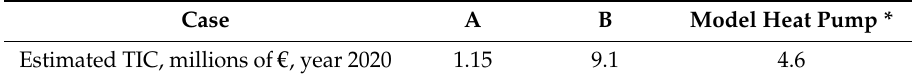
Table 10. Total investment cost (TIC) estimation for Case A, Case B, and model heat pump.